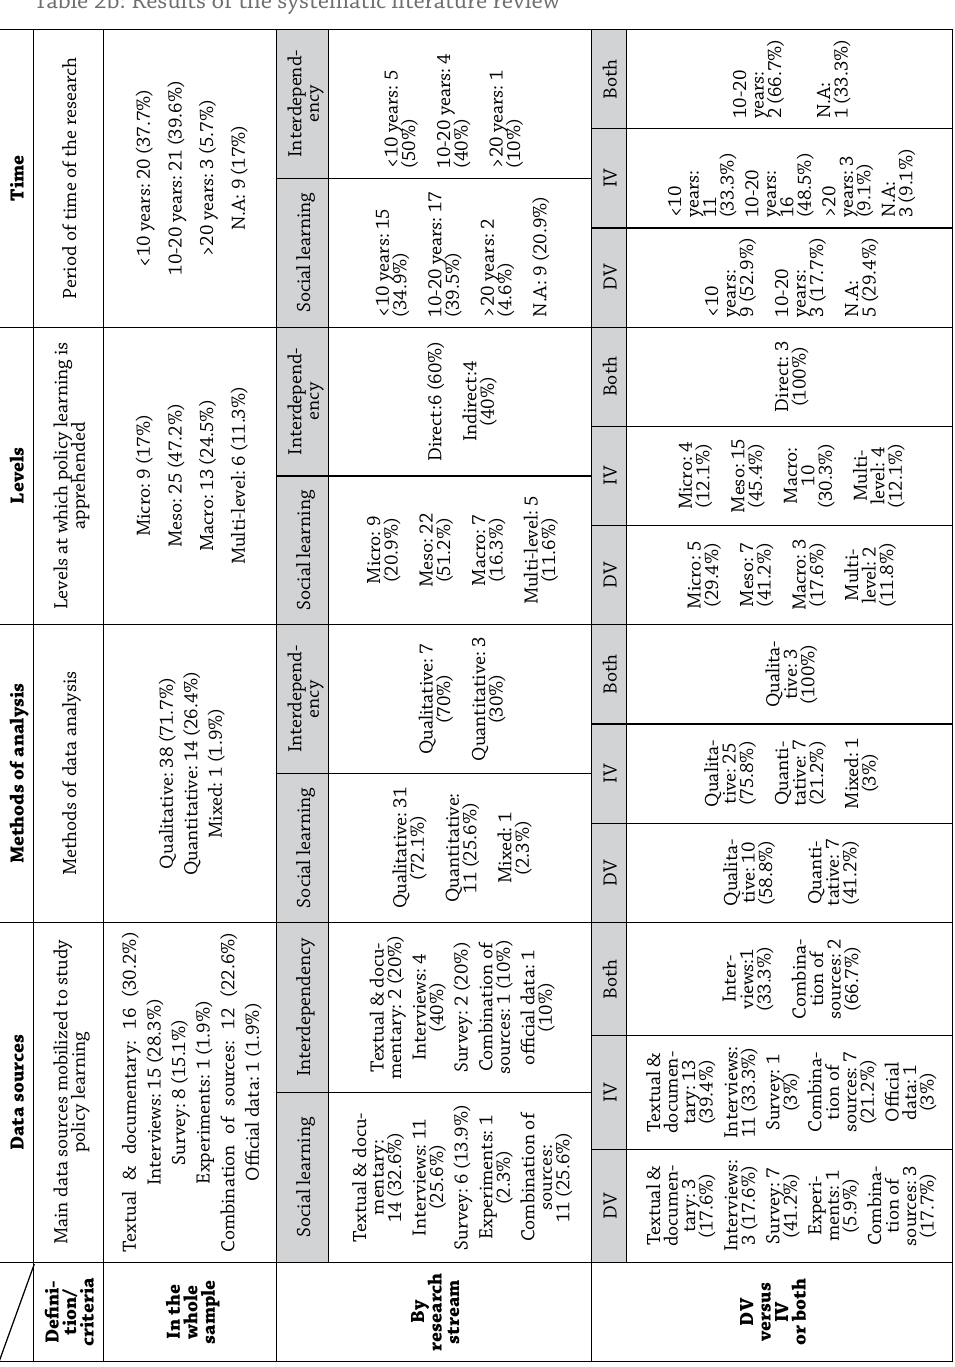
Table 2b: Results of the systematic literature